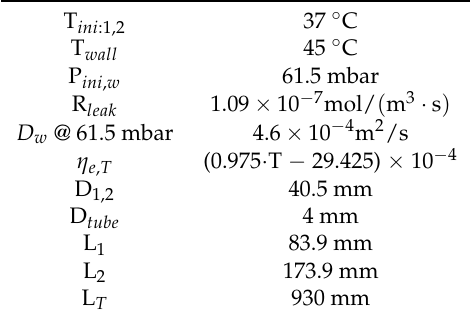
Table 1. Initial conditions and parameters used in the simulation for experiment 3, which is also shown in Figure 3. L x (x = 1, 2 and T) is the length of vessel 1 and 2 and the tube length between vessel 1 and 2,